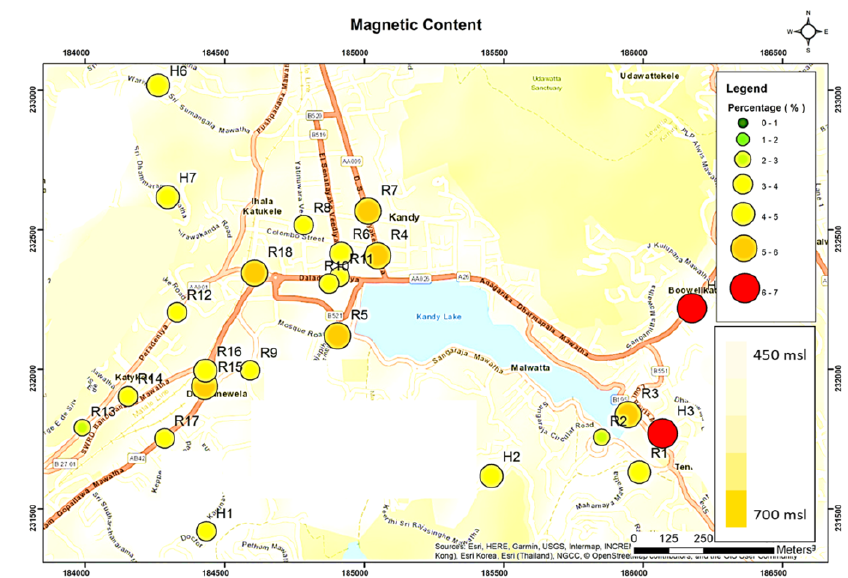
Figure 2: Map showing the distribution of magnetic materials in the study